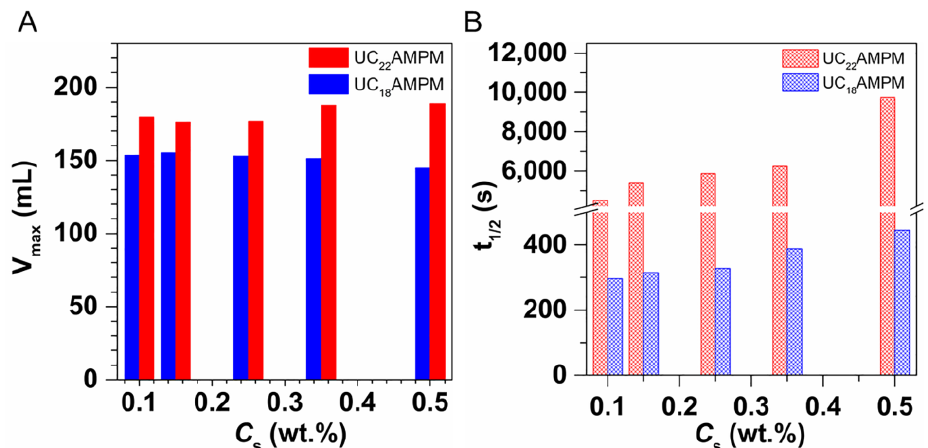
Figure 1. The influence of surfactant concentrations on ( A ) V max and ( B ) t 1/2 of UC 22 AMPM and UC 18 AMPM in atmospheric pressure at 35 °C, respectively. Table 1. CO 2 foam performance with different concentrations of UC 22 AMPM and UC 18 AMPM,